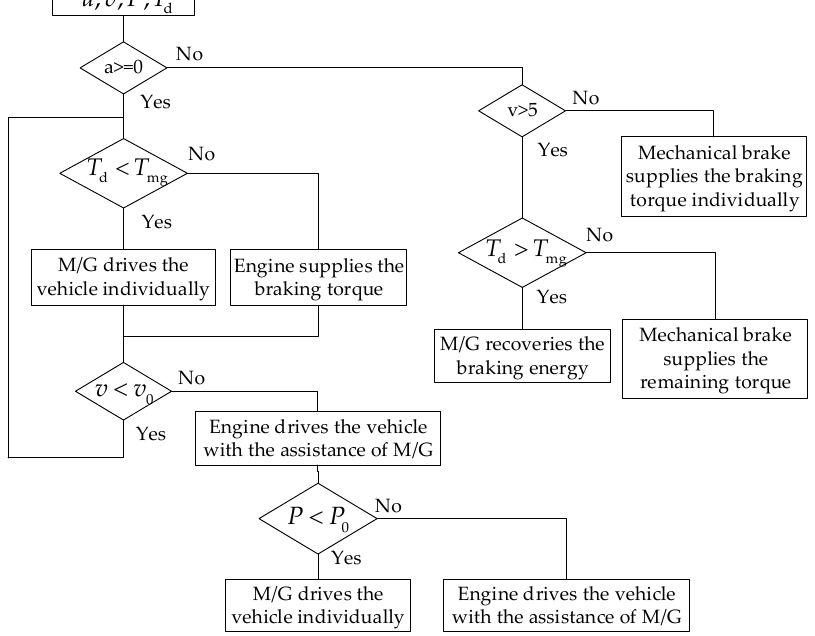
Figure 10. Power management strategy of the HEV.